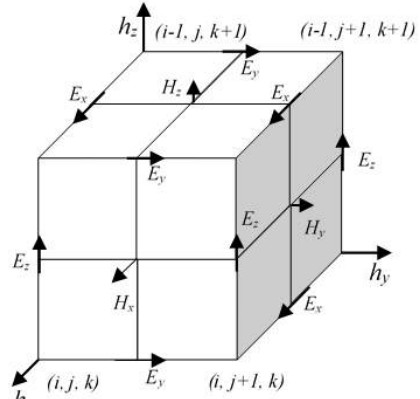
Figure 2. Yee cell model of an element with 3-D nonuniform meshes.